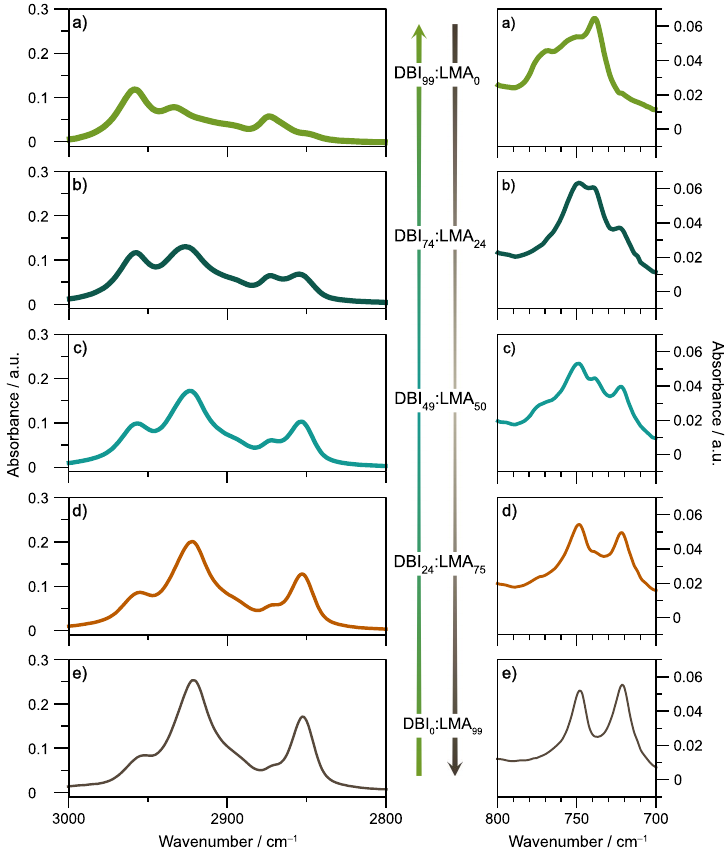
Figure 3. FTIR spectra of copolymers synthesized. ( a ) PSA-1000; ( b ) PSA-2000; ( c ) PSA-3000; ( d ) PSA-4000; ( e ) PSA-5000. 4000; ( e )